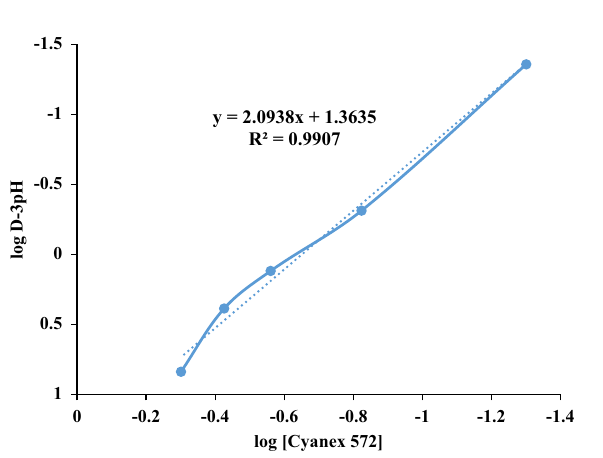
Figure 4. Effect of Cyanex 572 concentration on the distribution coefficient of cerium (contact time = 20 min, pH = 3, [NO